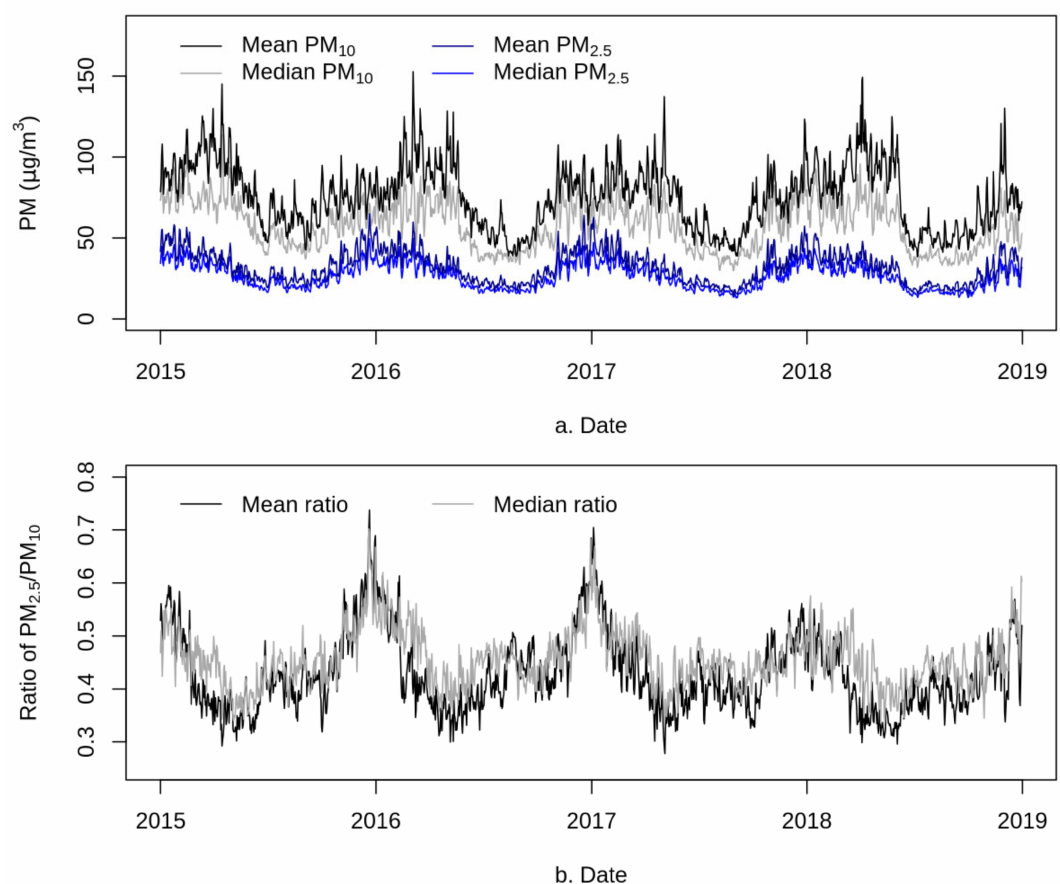
Figure 11. Time series plots of the means of predicted PM 2.5 and PM 10 concentrations ( a ) and their ratio ( b ) across mainland China.